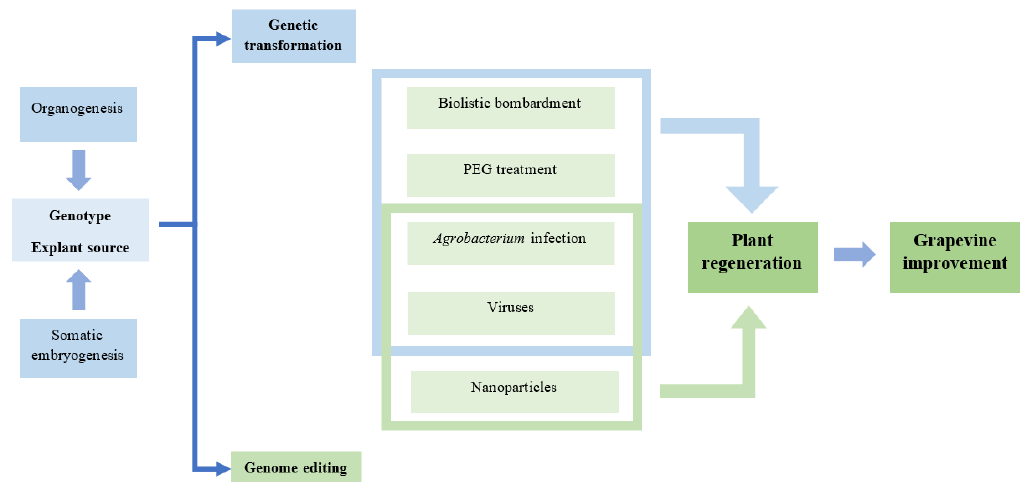
Figure 2. Diagram of grapevine genetic manipulation with transformation or editing.